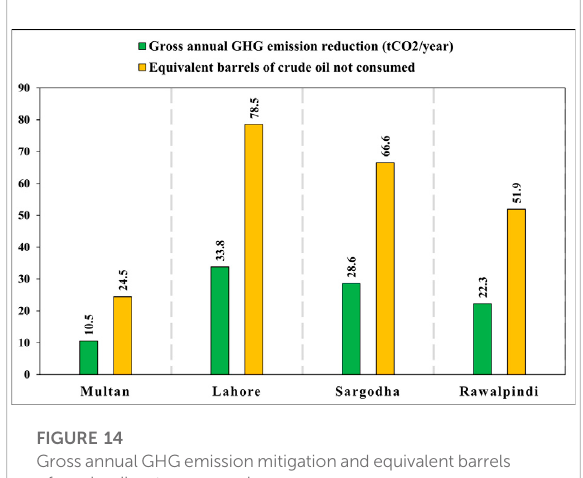
FIGURE 14 GrossannualGHGemission mitigationandequivalentbarrels of crude oil not